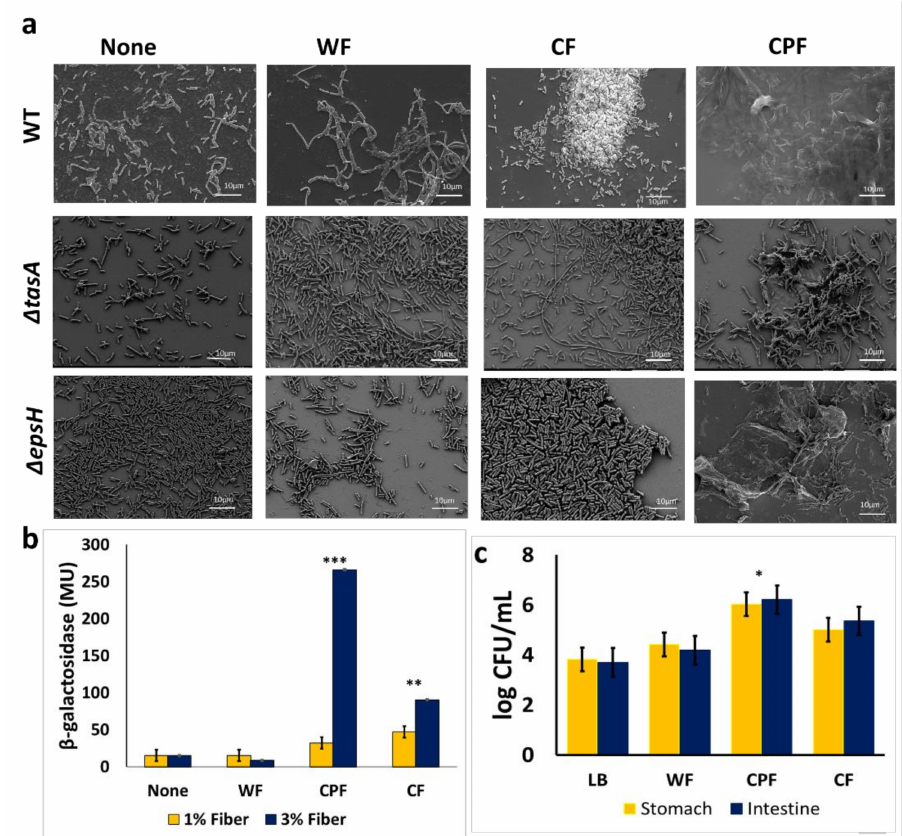
Figure 3. ( a ) An electron micrograph of B. subtilis cells (WT, ∆ tasA , and ∆ epsH ) following 16 h of growth in LB (unsupplemented control) and LB supplemented with different prebiotic substances (WF, CPF, or CF). Images were taken at 1500 × magnification. Scale bar: 10 µ m; ( b ) measurement